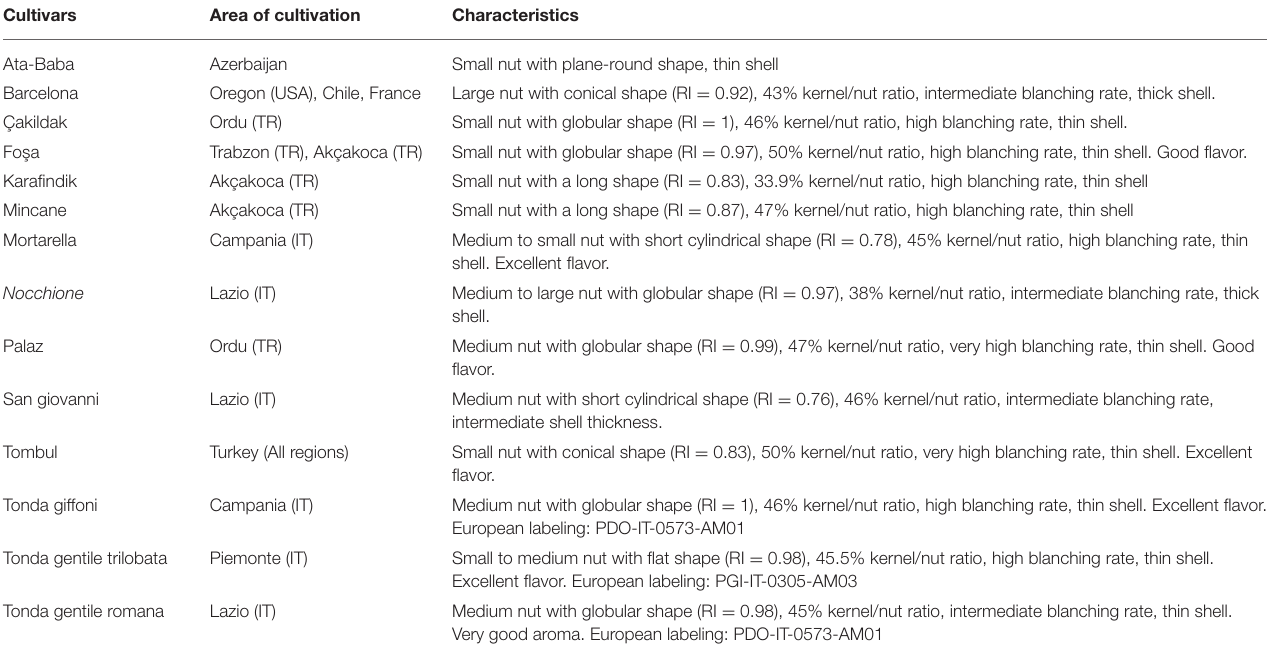
TABLE 2 | List of the most industrially used cultivars and their characteristics. Cultivars Area of cultivation Characteristics